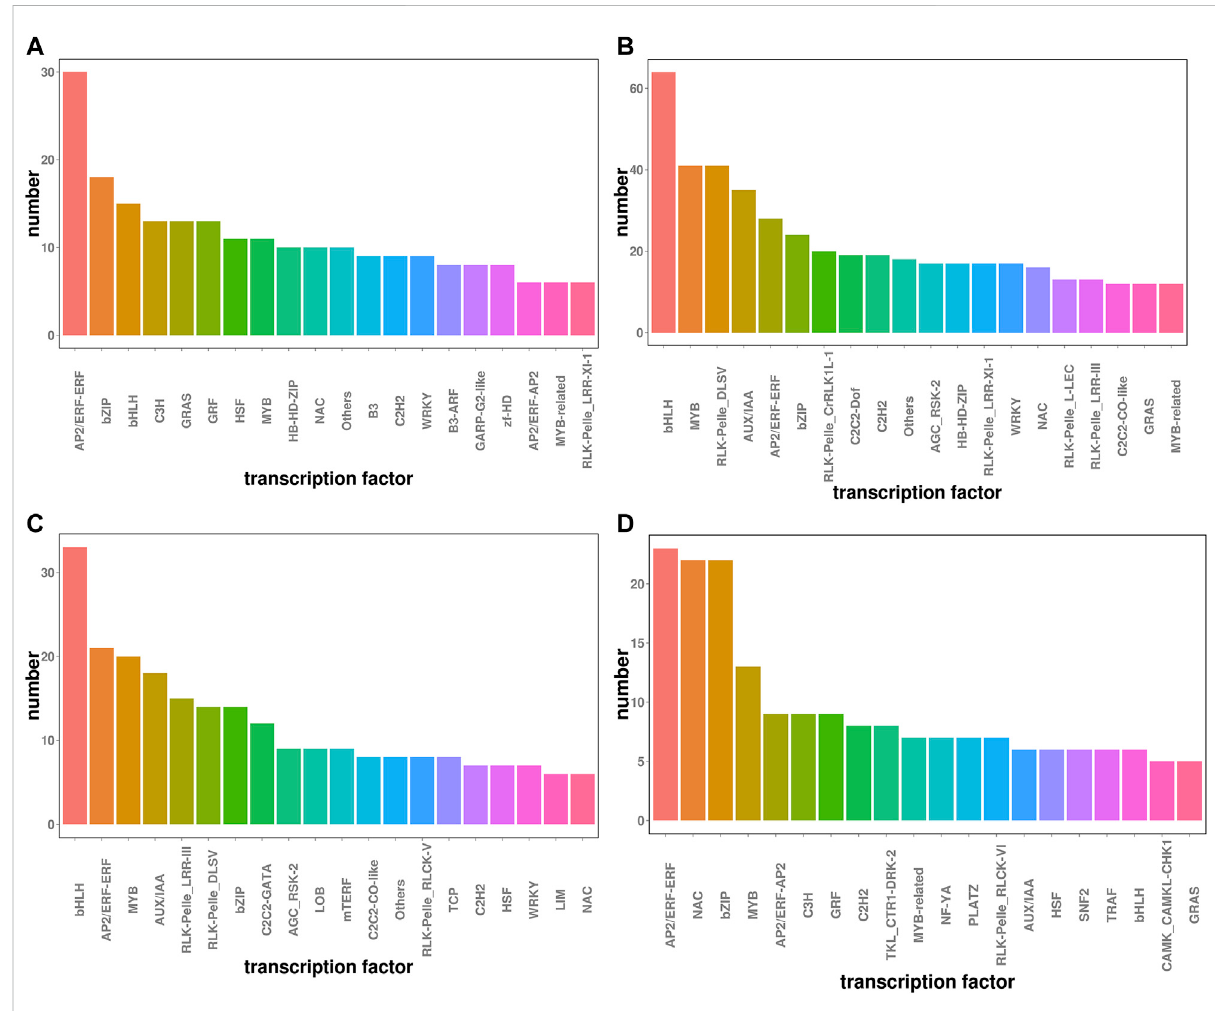
FIGURE 5 Transcriptionfactorstatisticsundertwotreatments (A) CKvs.Pupregulation (B) Ckvs.Pdownregulation (C) Pvs.S-Pupregulation (D) Pvs.S-P down regulation.